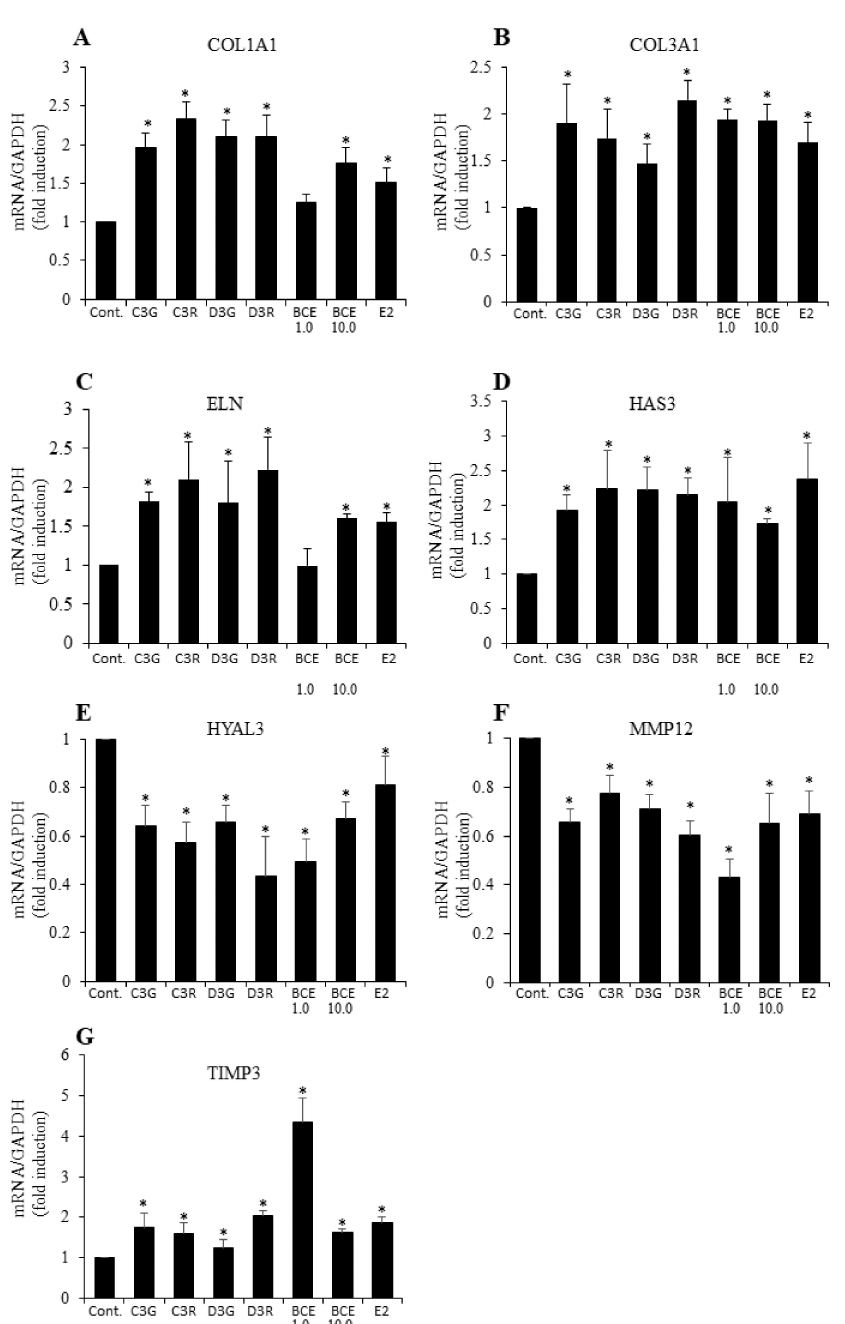
Figure 1. Effects of blackcurrant anthocyanins and 17 β -estradiol (E2) on mRNA levels of estrogen-dependent genes. TIG113 cells were treated with the indicated anthocyanins (10 µ M), BCE (1.0 or 10.0 µ g/mL), or E2 (1 nM) for 24 h. mRNA levels of ( A ) COL1A1 , ( B ) COL3A1 , ( C ) ELN , ( D ) HAS3 , ( E ) HYAL3 , ( F ) MMP12 , and ( G ) TIMP3 were quantified by RT-qPCR. Data represent the means ± standard errors of the mean of at least three independent experiments; * p < 0.05 vs. untreated control